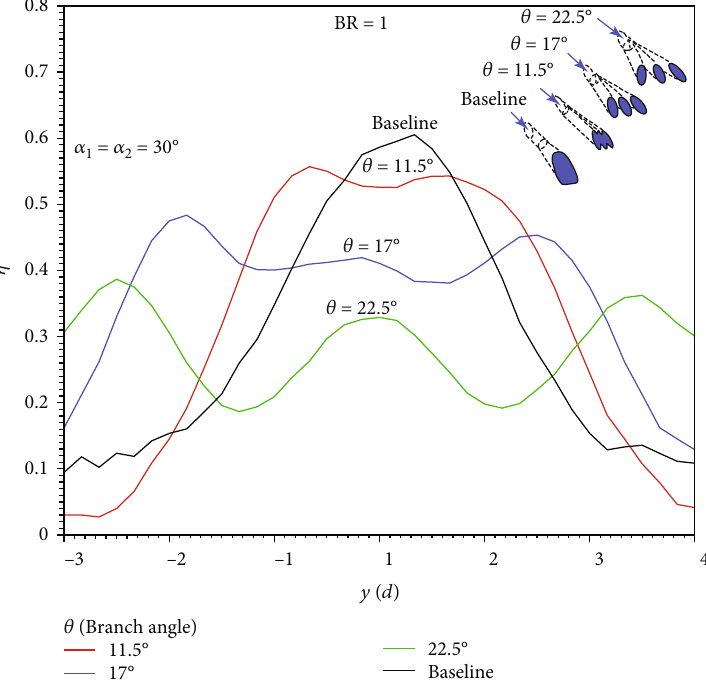
Figure 22: Spanwise (streamwise-averaged) fi lm e ff ectiveness variations at x / d = 5 for α ratio of BR = 1 .